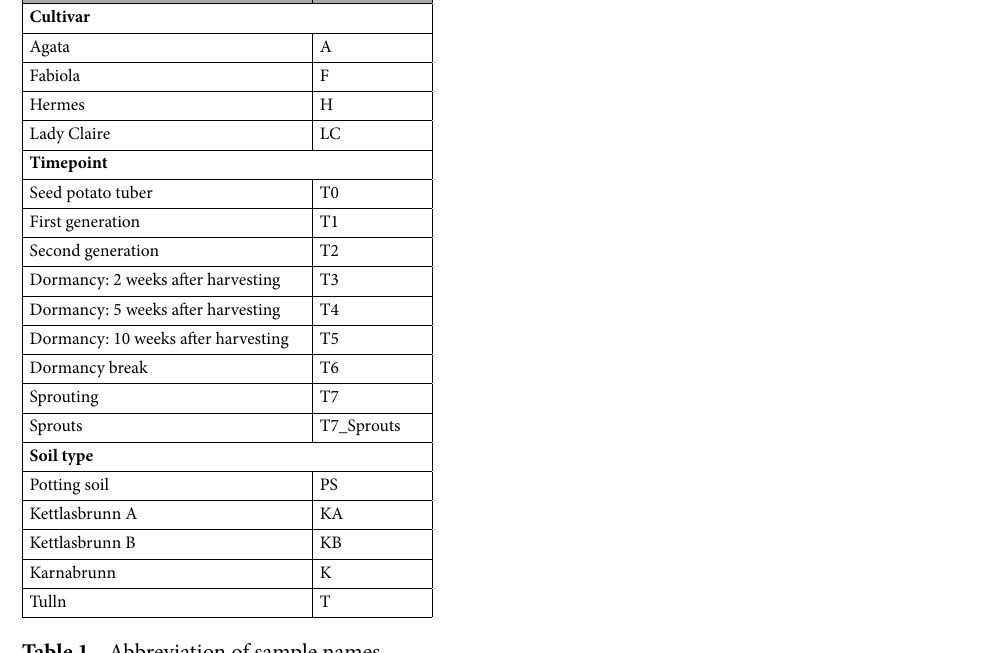
Table 1. Abbreviation of sample names.